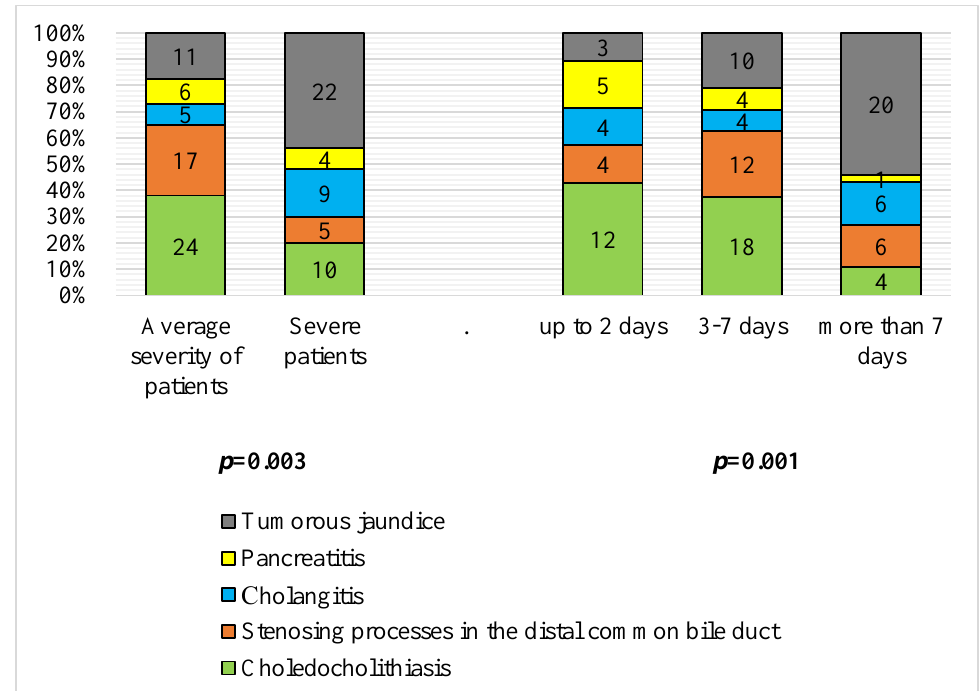
Figure 2. Distribution of patients with different causes of obstructive jaundice by severity ( p = 0.003) and duration ( p = 0.001); criterion X 2 ( n = 113).